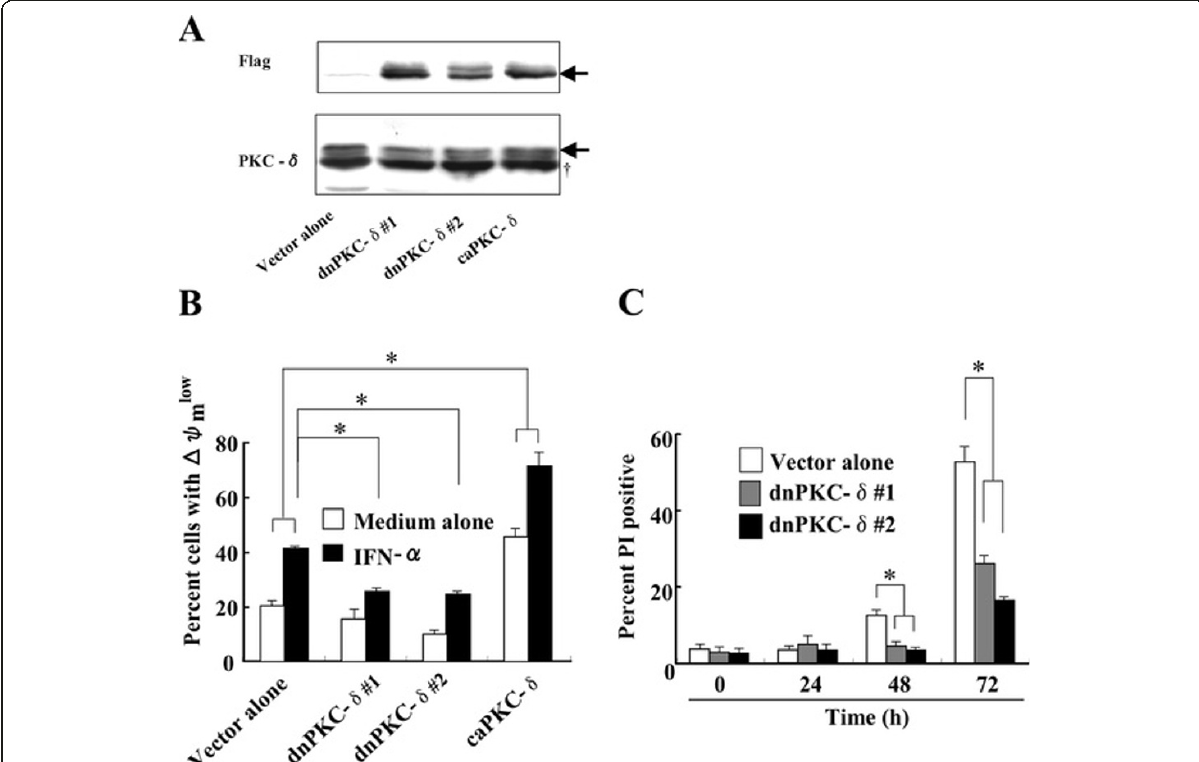
Figure 4 IFN- a -induced loss of mitochondrial membrane potential and apoptosis are partially abrogated in dnPKC- δ -expressing cells, while somewhat enhanced in caPKC- δ -expressing cells . Daudi cells were transfected with Flag-dnPKC- δ , Flag-caPKC- δ , or the control vector alone, and incubated with selection media containing hygromycin B, followed by limiting dilution to obtain clone(s). The resulting clones were confirmed to express Flag-dnPKC- δ or Flag-caPKC- δ (A). These clones were stimulated with 1,000 U/ml IFN- a for the indicated time periods, followed by assays for mitochondrial membrane potential (B, 48 h-incubation) and PI positive cells (C). Arrow indicates specific band for PKC- δ . † , non-specific band. The results from three independent experiments (B&C) are represented as mean ± SD. *Significantly different ( p < 0.05) from control vector